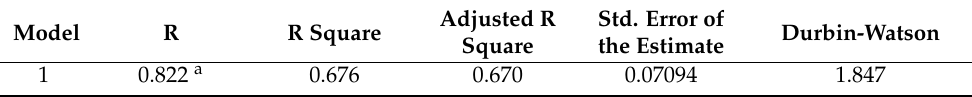
Table 4. Results of model summary.